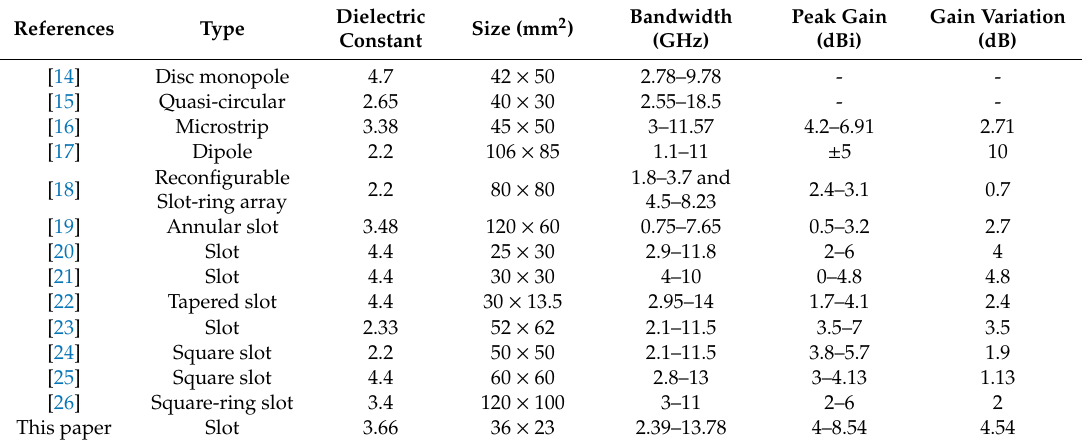
Figure 16. Measured peak gains of the antenna. Table 2. Comparison of the published UWB antennas.